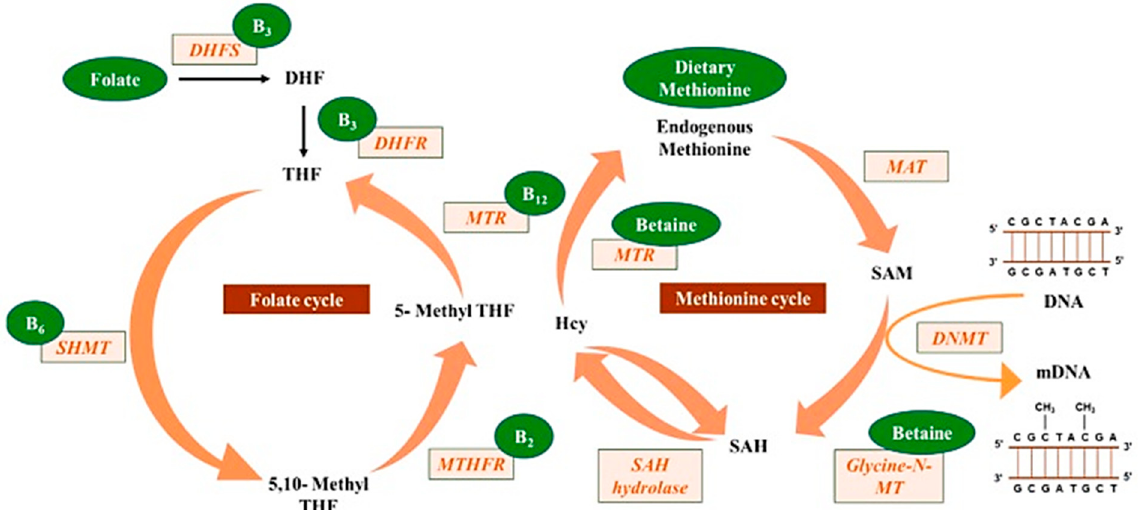
Figure 2. Methyl donors from micronutrients are involved in the one-carbon metabolism, contributing to DNA methylation (reprinted from Mahmoud and Ali (2019) [20]).